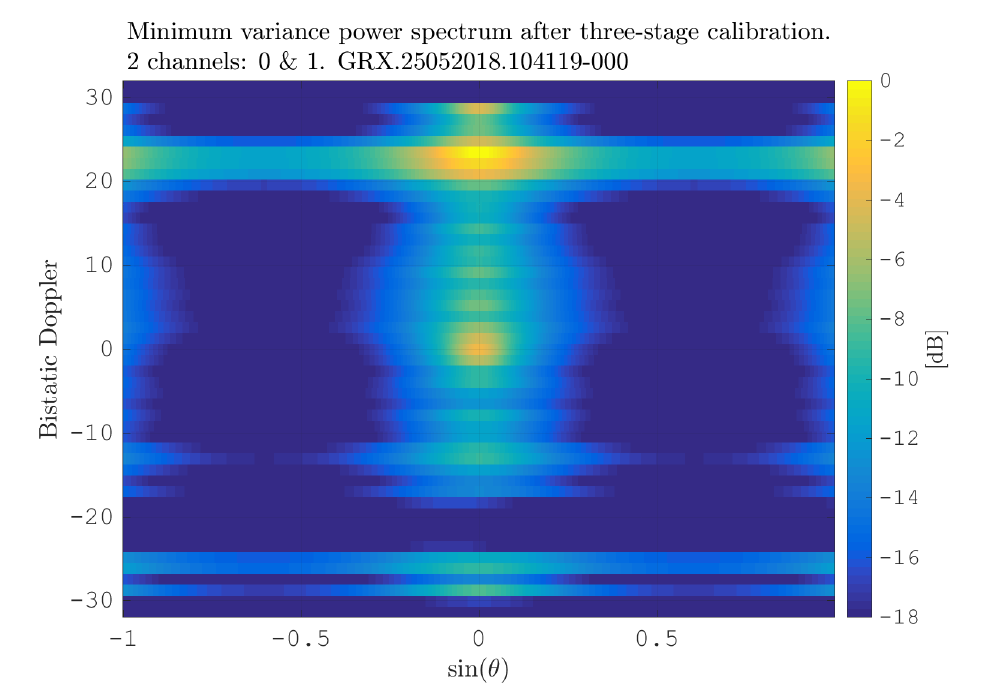
Figure 18. MV power spectrum after calibrations using CDS and MVPS.